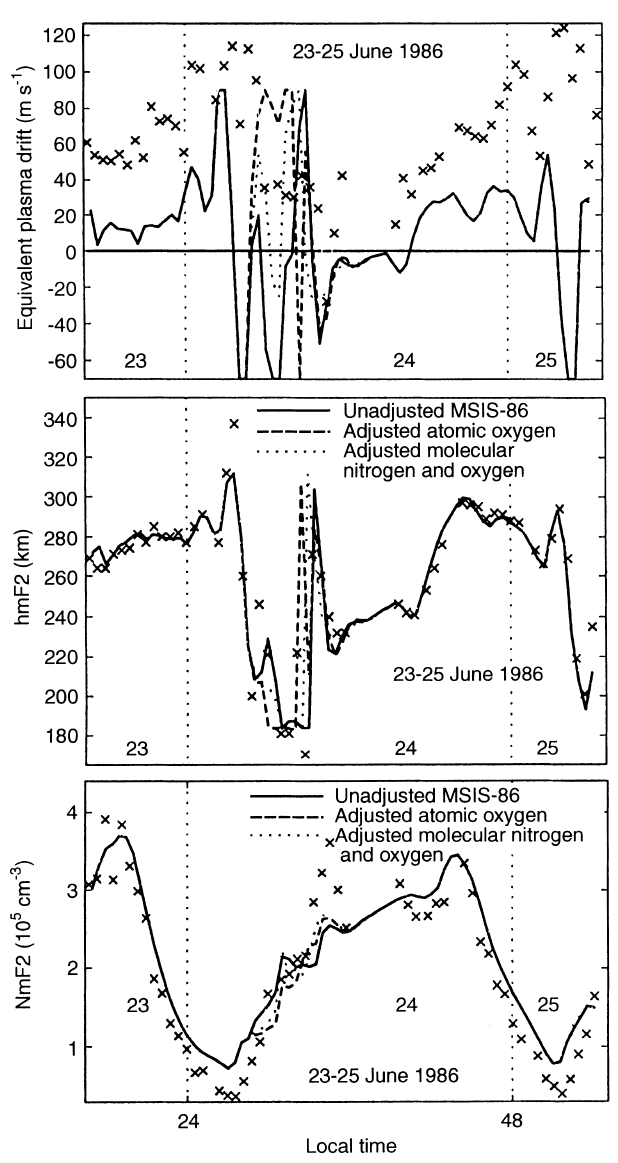
Fig. 1. Observed ( crosses ) and calculated ( lines ) parameters above Millstone Hill for 23–25 June 1986. Top: equivalent plasma drift velocity; middle:hmF2; bottom:NmF2. The solid lines show results from the IZMIRAN model using the unadjusted MSIS-86 neutral atmosphere model. Dashed and dotted lines show e(cid:128)ects of adjustments to the MSIS-86 model between 0500 LT and 0800 LT on 24 June at all altitudes. Dashed lines show results when the MSIS- 86 model [O] was decreased by a factor 1.6. Dotted lines show results when the MSIS-86 model [N ] and [O ] were increased by a factor of 2 2 2